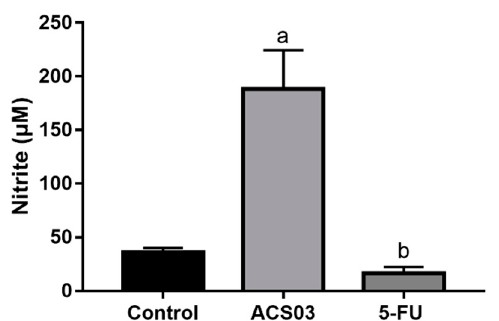
Figure 3. Effect of ACS03 (12.5 mg/kg) and 5-FU (25 mg/kg) on quantification of nitrite in the peritoneal fluid of Ehrlich ascites carcinoma transplanted mice. Data are presented as mean ± SEM of six animals analyzed by analysis of variance (ANOVA) followed by Tukey’s test. a p < 0.05 compared to tumor control group. b p < 0.05 compared to ACS03.